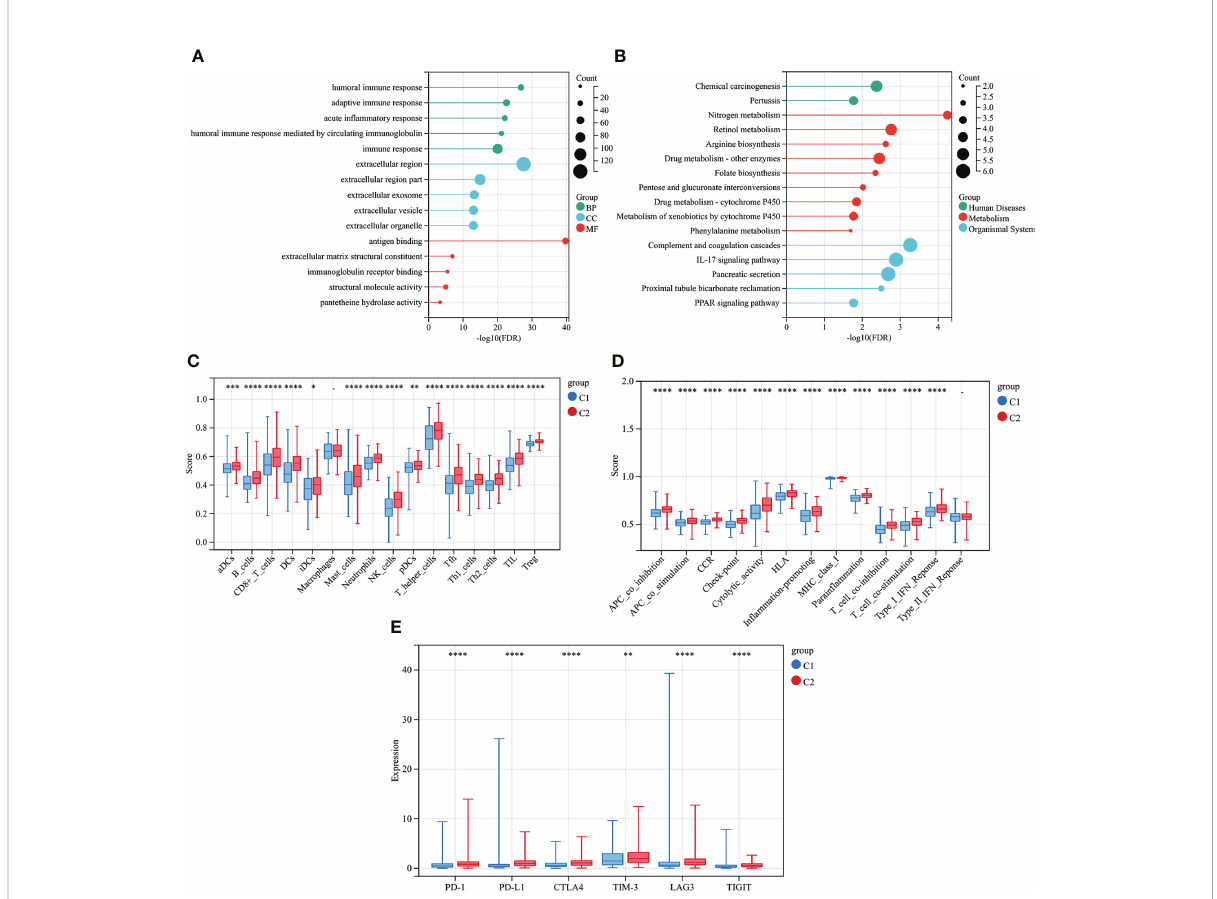
FIGURE 6 Differential immune characteristics of CMRGs pattern C1 and C2. (A) GO Lollipop graph for genes in BP, CC, and MF. (B) Lollipop graph of KEGG pathways with the most enriched genes; the vertical axis refers to names of the pathway; and the horizontal axis refers to the number of genes. (C) Relative in fi ltration of 16 types of immune cells in CMRGs cluster C1 and C2. (D) Relative enrichment score of 13 immune related functions in CMRGs cluster C1 and C2. (E) Differences in expression of immune checkpoint - related genes between C1 and C2. 0 ≤ ****<0 .0001 ≤ ***